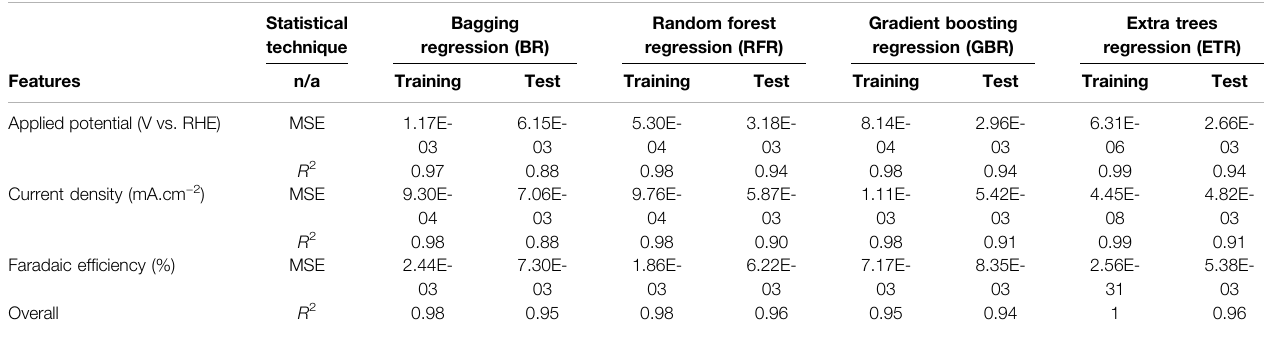
TABLE 4 | Evaluation of predictive algorithms for applied potential, faradic ef fi ciency and current